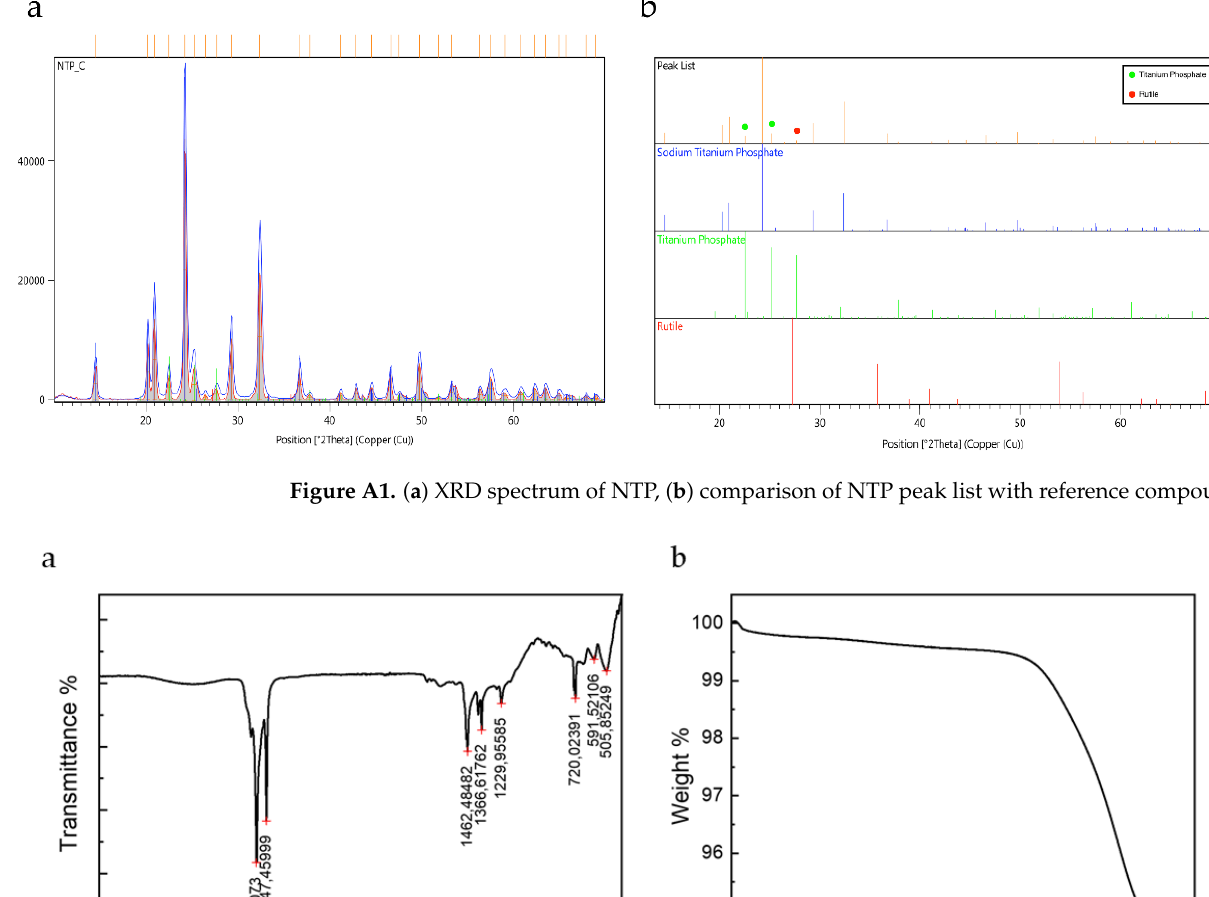
Figure A2. ( a ) FTIR spectrum of NTP and ( b ) TGA curve.